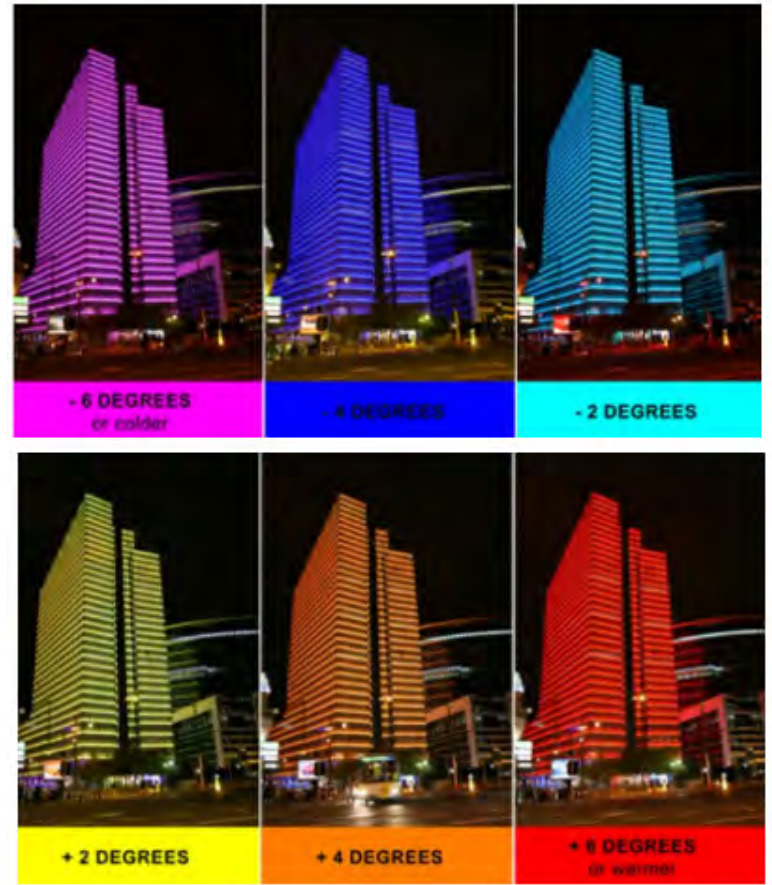
Figure 4. Weather tower, Brussels; (Wiederker, 2011)